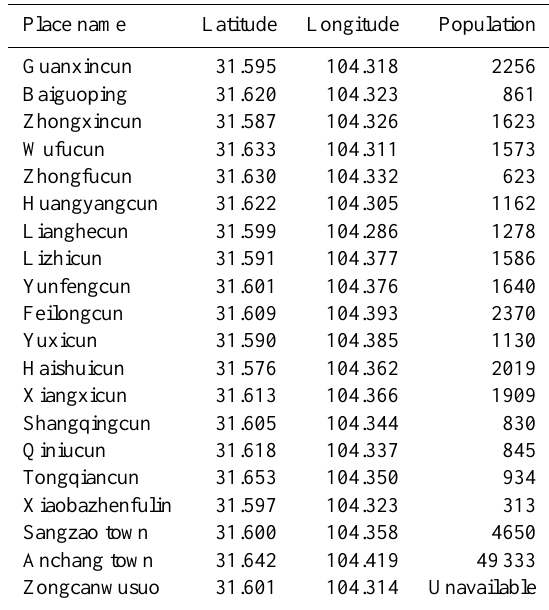
Table 4. Population distribution in inundation